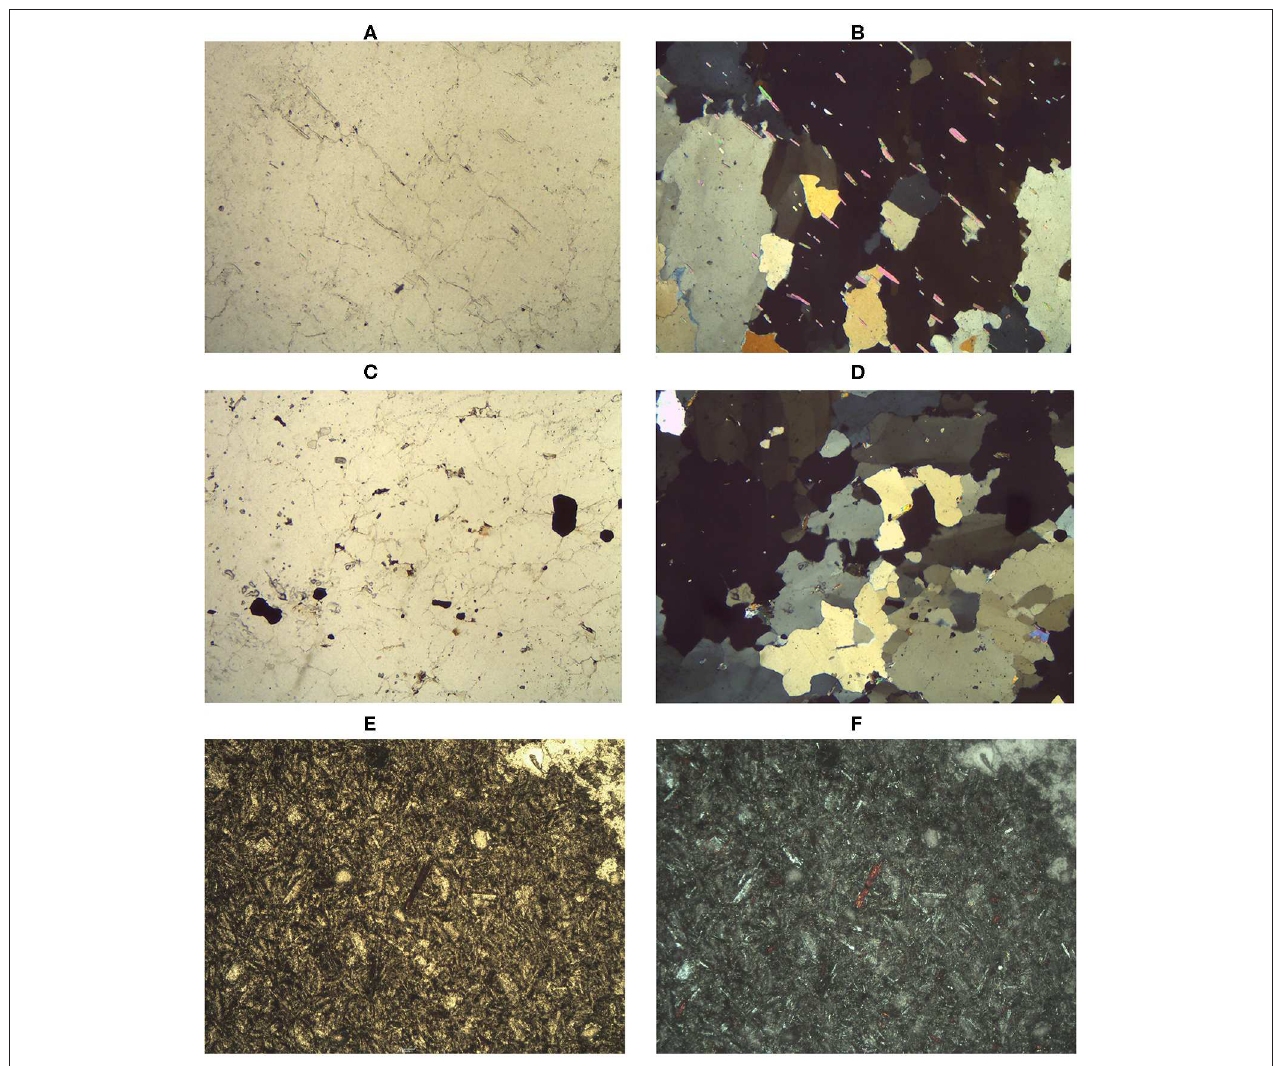
FIGURE 8 | Naisiusiu 14: (A) Quartz and muscovite (PPL 2 × horizontal field width 1.1mm); (B) same as (A) quartz crystals show undulatory extinction and sutured boundaries (XP); Oittii 1A: (C) large idioblastic rutile crystals (PPL 2 × horizontal field width 1.1mm); (D) same as (C) quartz crystals show undulatory extinction, and muscovite crystals are fragmented and have a random lineation (XP); A6: (E) kaersutite crystals included in a felty groundmass (PPL 4 × horizontal field width 0.55mm); (F) same as (E) note the distinctive red kaersutite crystals